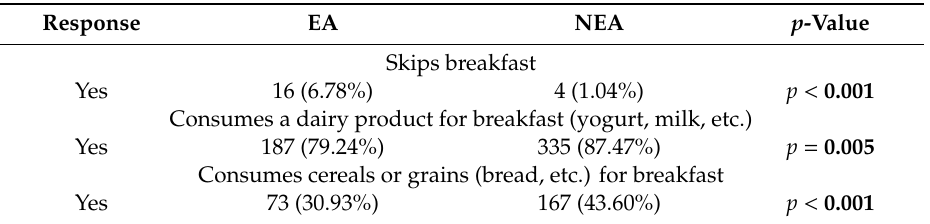
Table 2. Children’s foods habits according to